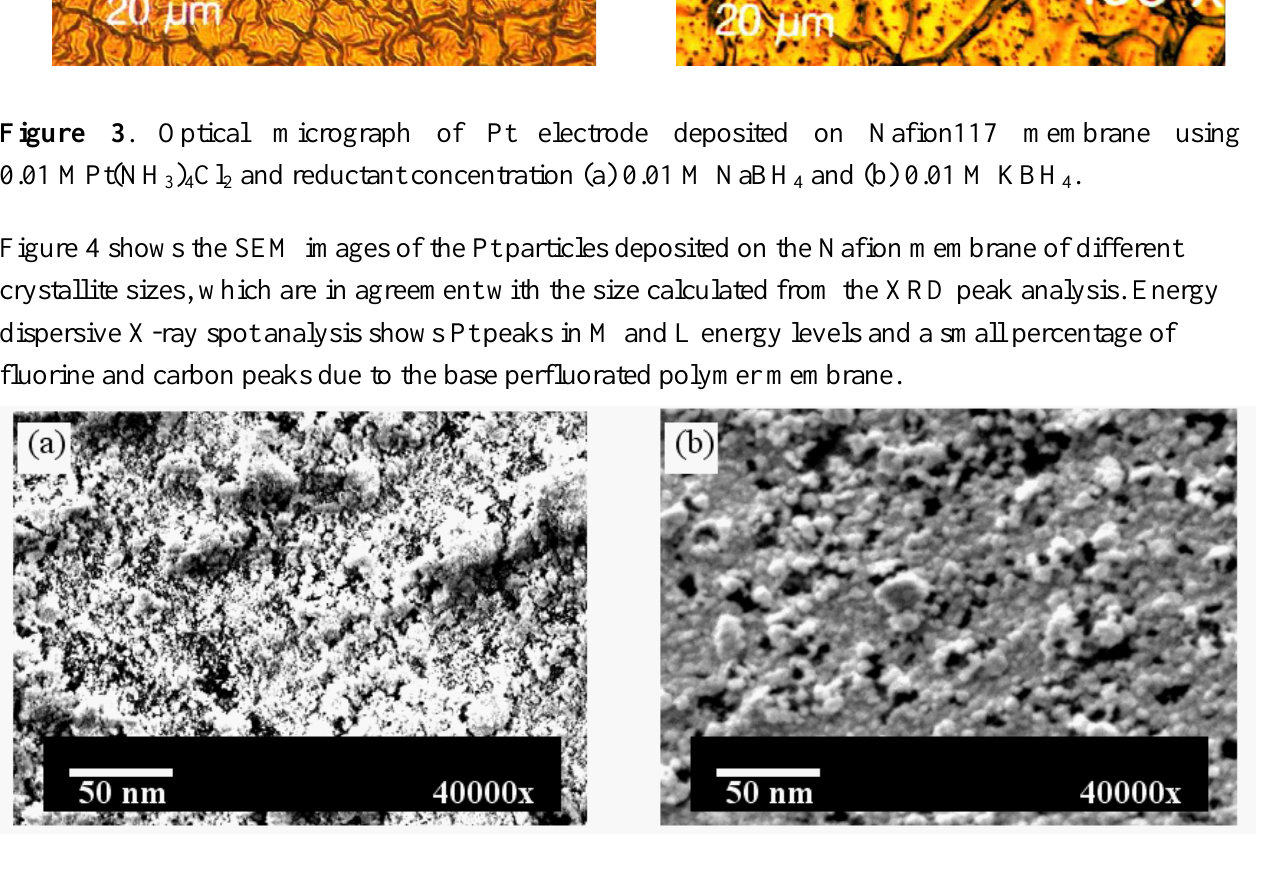
and (b) 0.01 M KBH 4